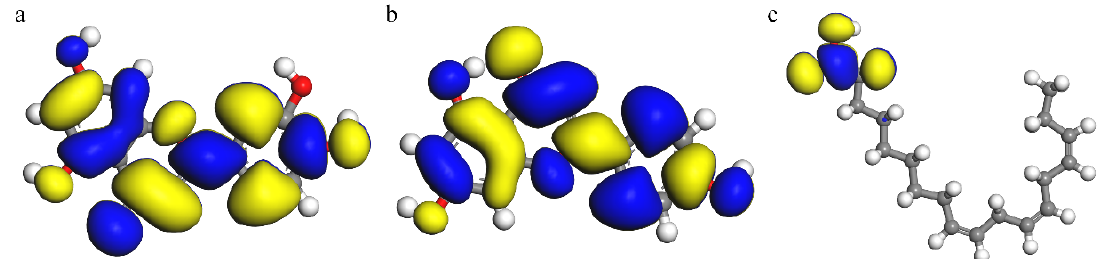
Figure 10. HOMO: ( a ) luteolin, ( b ) apigenin and ( c ) α -linolenic acid.